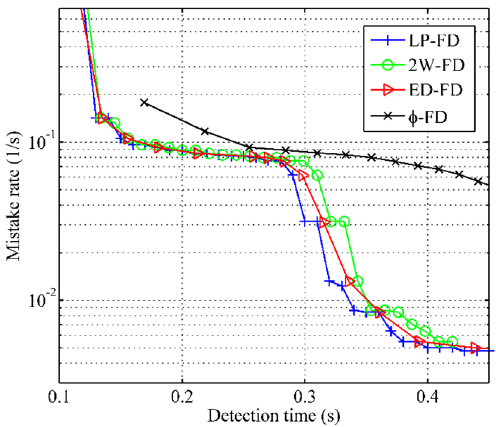
Figure 5. Mistake rate vs. detection time.